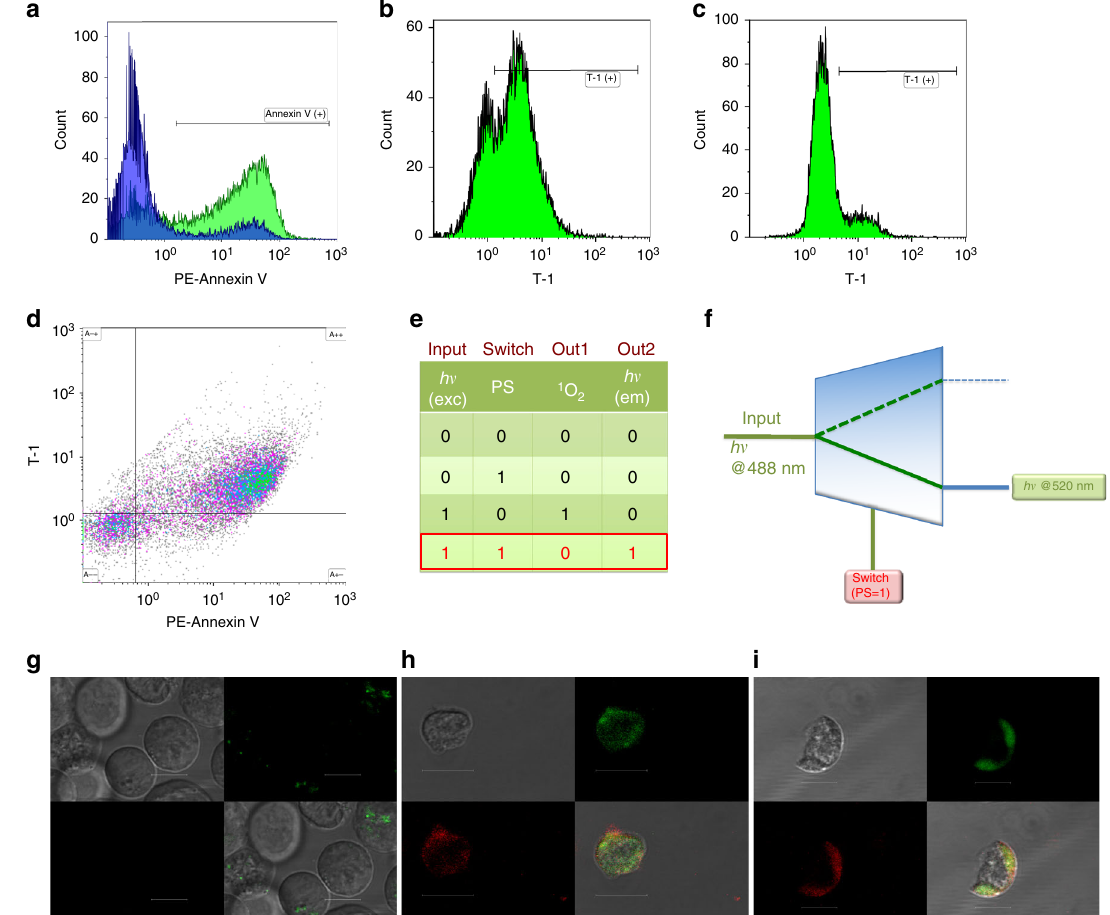
Fig. 4 T-1 signals apoptosis by switching to diagnostic mode. a PE-Annexin labels most of the cells incubated with T-1 under light irradiation (Annexin V ( + ) region of the green area). b Green channel: cells incubated with T-1 under irradiation. c Green channel: cells incubated with T-1 in the dark. d The 2D plot for both green and red channels: T-1 and PE-Annexin V (a speci fi c apoptosis marker) stain the same kind of cells with a large (86%) agreement: 70% of the irradiated cells were co-stained with both T-1 and PE-Annexin V, indicating only apoptotic cells are fl uorescently labeled with T-1 . e The truth table with input, the switch and the outputs clearly identi fi ed, and the particular set of conditions were highlighted. f Switch input (appearance of phosphatidylserine in the external lea fl et of the cell membrane) selects fl uorescence emission as the primary output. g Cells treated with PE-Annexin V and the T-1 , and kept in dark, show no signs of morphological change, and the cellular membranes are not stained with either one of the agents. h , i Cells were incubated with T-1 , irradiated with the LED light source, then treated with PE-Annexin V. The two agents ( T-1 and PE-Annexin V, green and red, respectively) label the same regions in the cells undergoing apoptosis. (scale bar, 10 μ